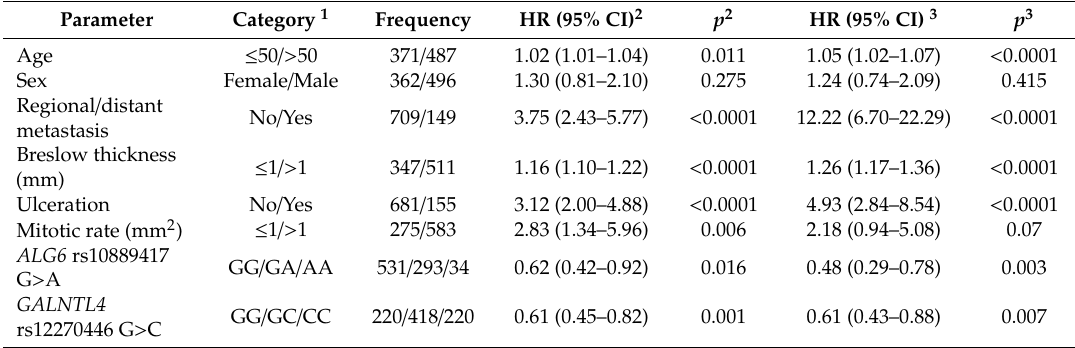
Table 2. Two independent SNPs in a stepwise multivariable Cox regression analysis with adjustment for other covariates and previous published SNPs in The University of Texas MD Anderson Cancer Center (MDACC)